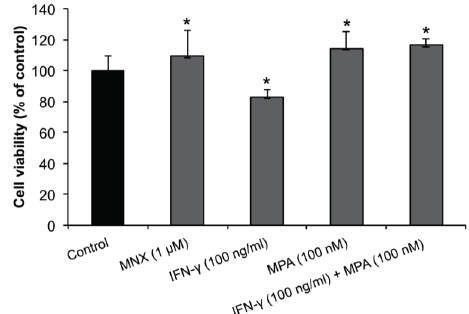
Figure 1. Mycophenolate (MPA) promotes human dermal papilla cell (hDPC) proliferation and abrogates IFN- γ -mediated hDPC reduction. hDPCs were treated with 100 ng/mL of IFN- γ , 100 nM of MPA, or with both IFN- γ and MPA for 3 days, and MTT assay was assessed on day 3. MNX served as a positive control for hDPC promotion. Results were expressed as mean ± SEM of percent change compared to the control. Statistically significant differences were determined by ANOVA ( * p <